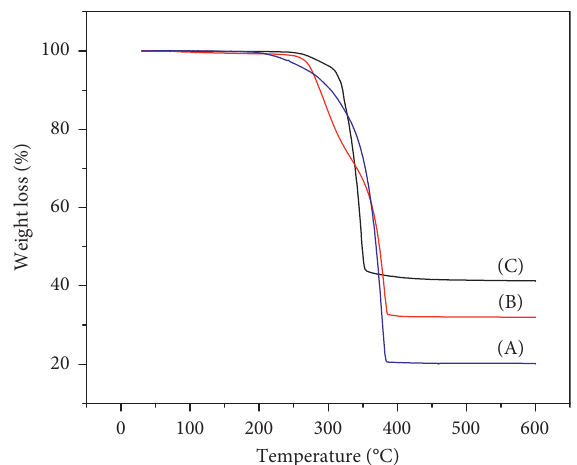
Figure 3: TGA plot of (A) Pb[(SeP i Pr